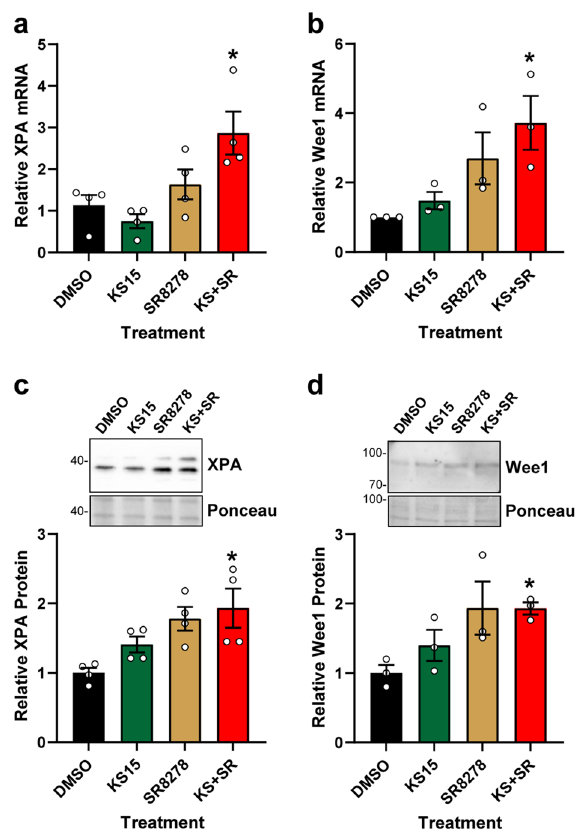
Figure 3. KS15 and SR8278 treatment increase XPA and Wee1 expression in U2OS cells. (a) U2OS cells were treated with DMSO vehicle, 20 µM KS15, 10 µM SR8278, or the combination of KS15 and SR8278 (KS + SR) for 24 h. RNA was purified and analyzed for XPA mRNA expression by RT-qPCR (average and SEM, n = 4). (b) Wee1 mRNA was analyzed as in (a) . (c) Cell lysates from cells treated as in (a) were analyzed for XPA protein by immunoblotting (average and SEM, n = 4). (d) Wee1 protein expression was analyzed as in (c) . Full-length blots are presented in Supplementary Figure S1. The asterisks indicate differences in mRNA protein expression in comparison to DMSO-treated control cells (p < 0.05; one-way